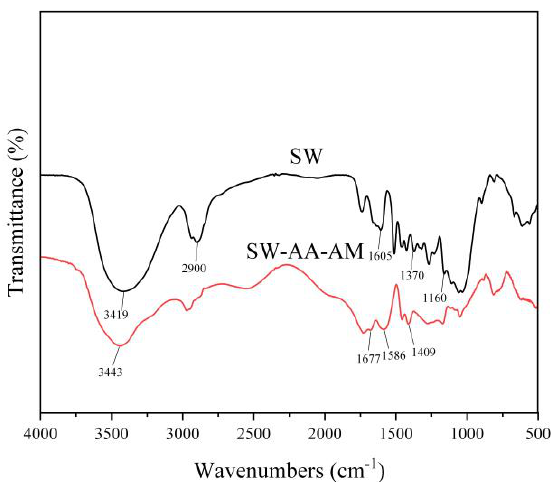
Figure 1. FTIR spectra of sawdust and the sawdust-graft-acrylic acid-graft-acrylamide (SW-AA-AM) polymer.